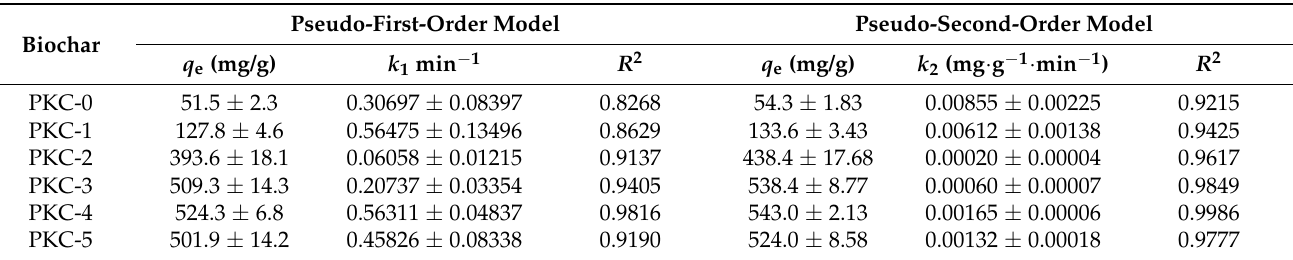
Table 2. Adsorption kinetic parameters of pseudo-first-order model and pseudo-second-order model for OTC adsorption on biochars.